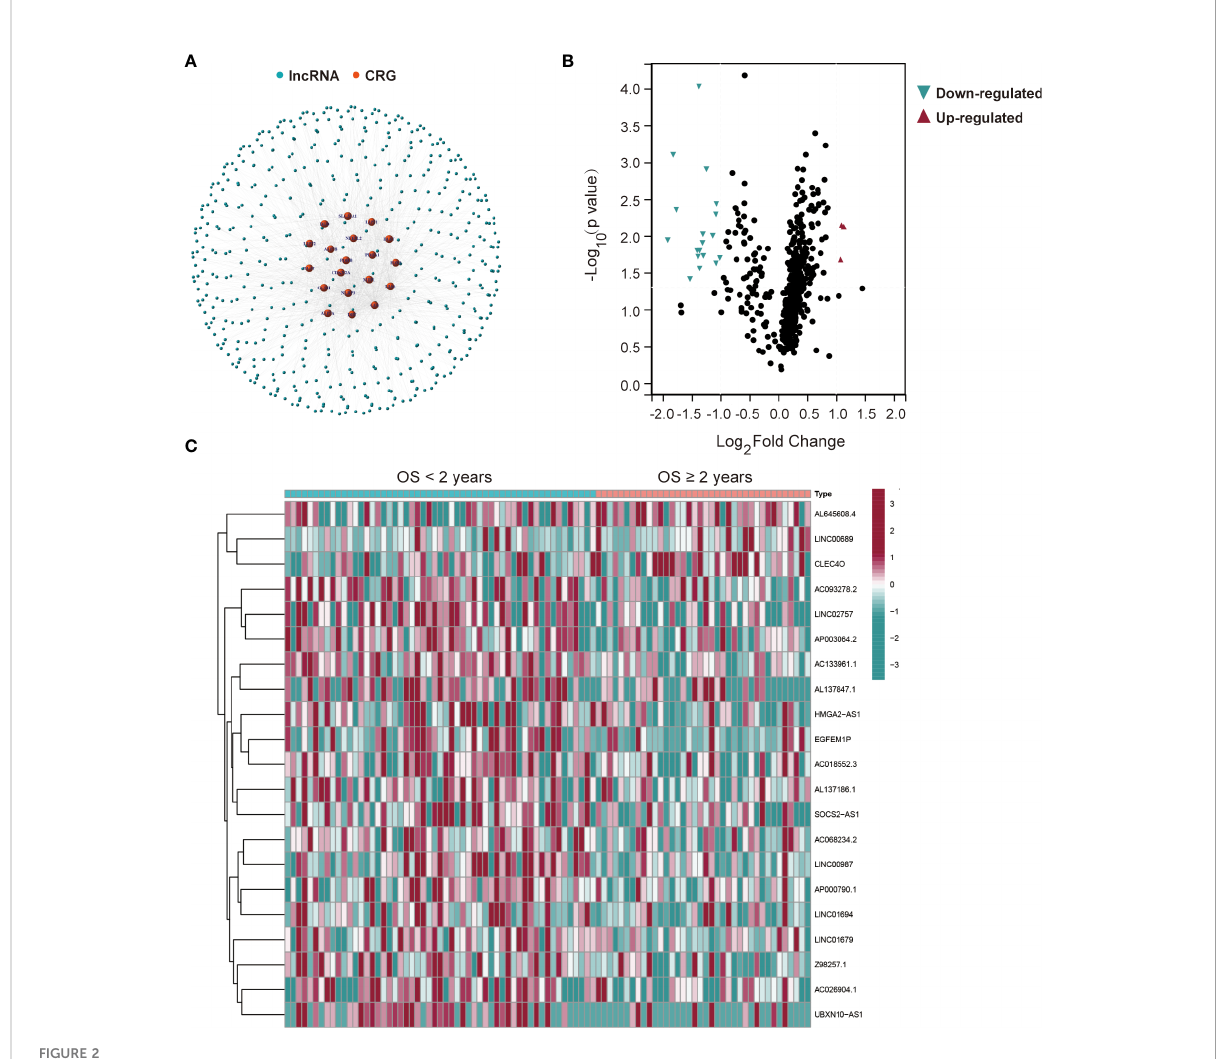
FIGURE 2 Twenty-one differentially expressed cuproptosis-related lncRNAs in AML patients from the TCGA database. (A) The network between 19 cuproptosis-related genes (CRGs) and 503 lncRNAs in AML patients (correlation coef fi cients > 0.4 and p < 0.001). (B) Differentially expressed lncRNAs for AML patients based on the OS < or ≥ 2 years. (C) A heatmap of the twenty-one differentially expressed